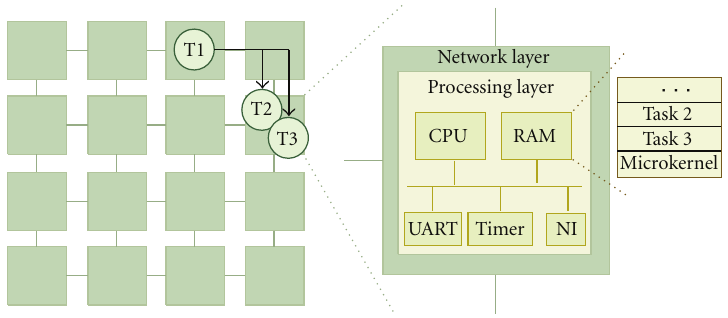
Figure 2: NPU structural description.